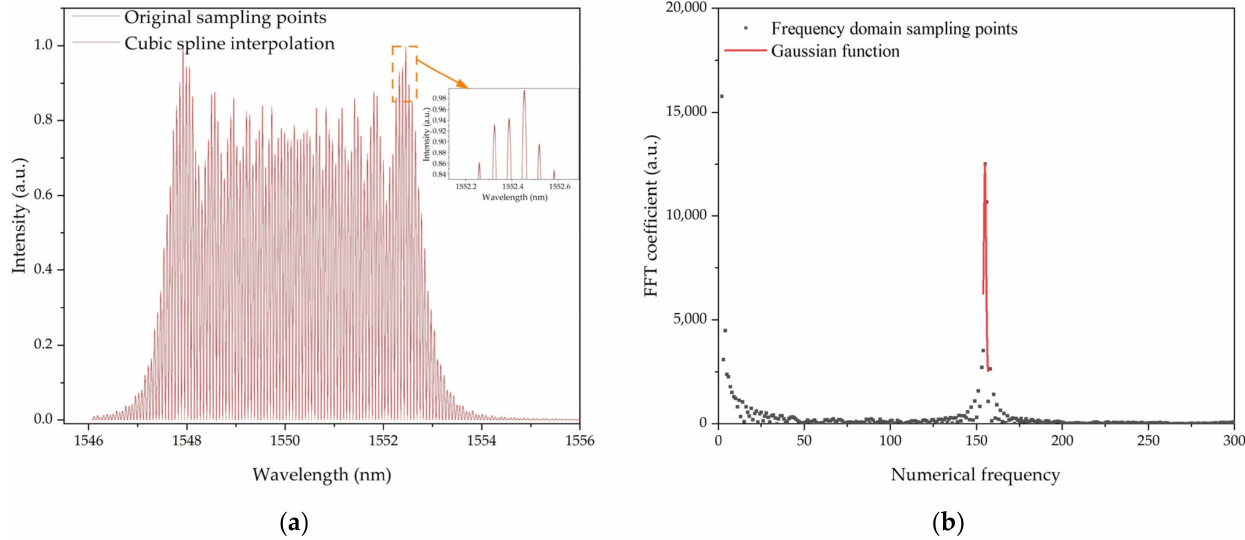
Figure 4. Simulated results of CFBG-FP. ( a ) Cubic spline interpolation results and original sampling points of the interference light intensity. ( b ) Amplitude frequency response characteristic of the interference light